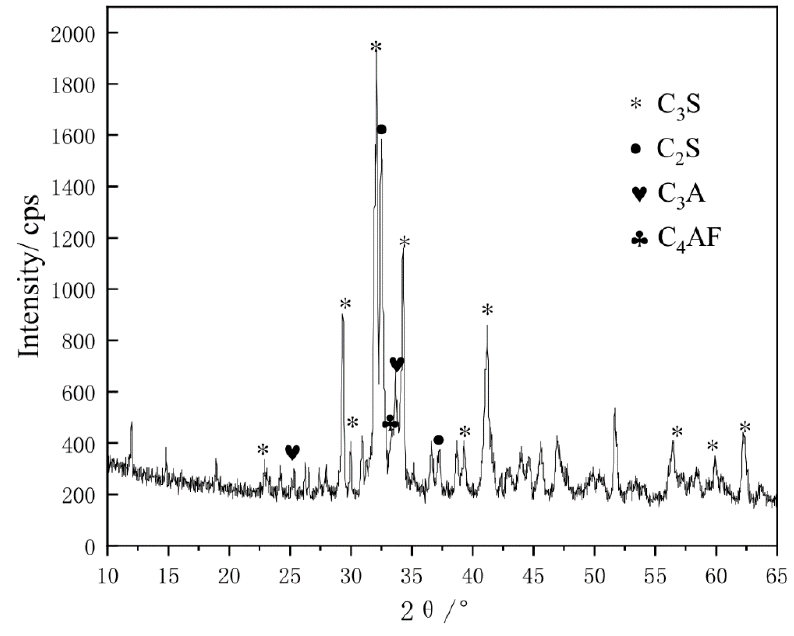
Figure 1. XRD pattern of PLH.